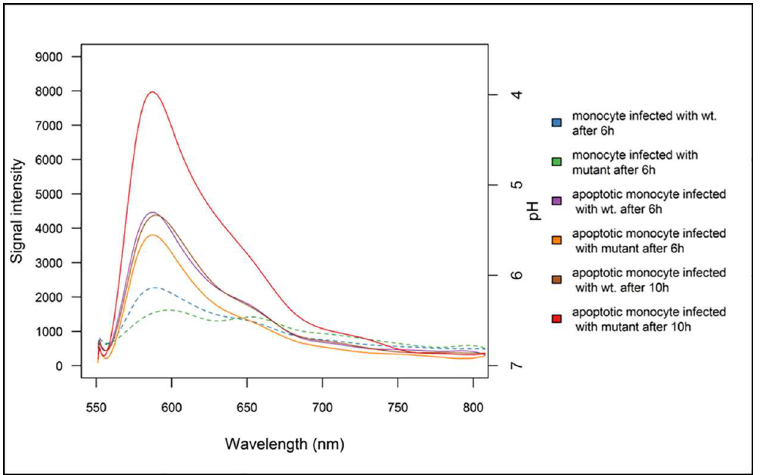
Fig 3. Spectrum of the pH at given time points (6 h and 10 h p.i.) in apoptotic and non-apoptotic infected monocytes. The dashed lines (shown in blue and green) are the spectra of pH in wild-type